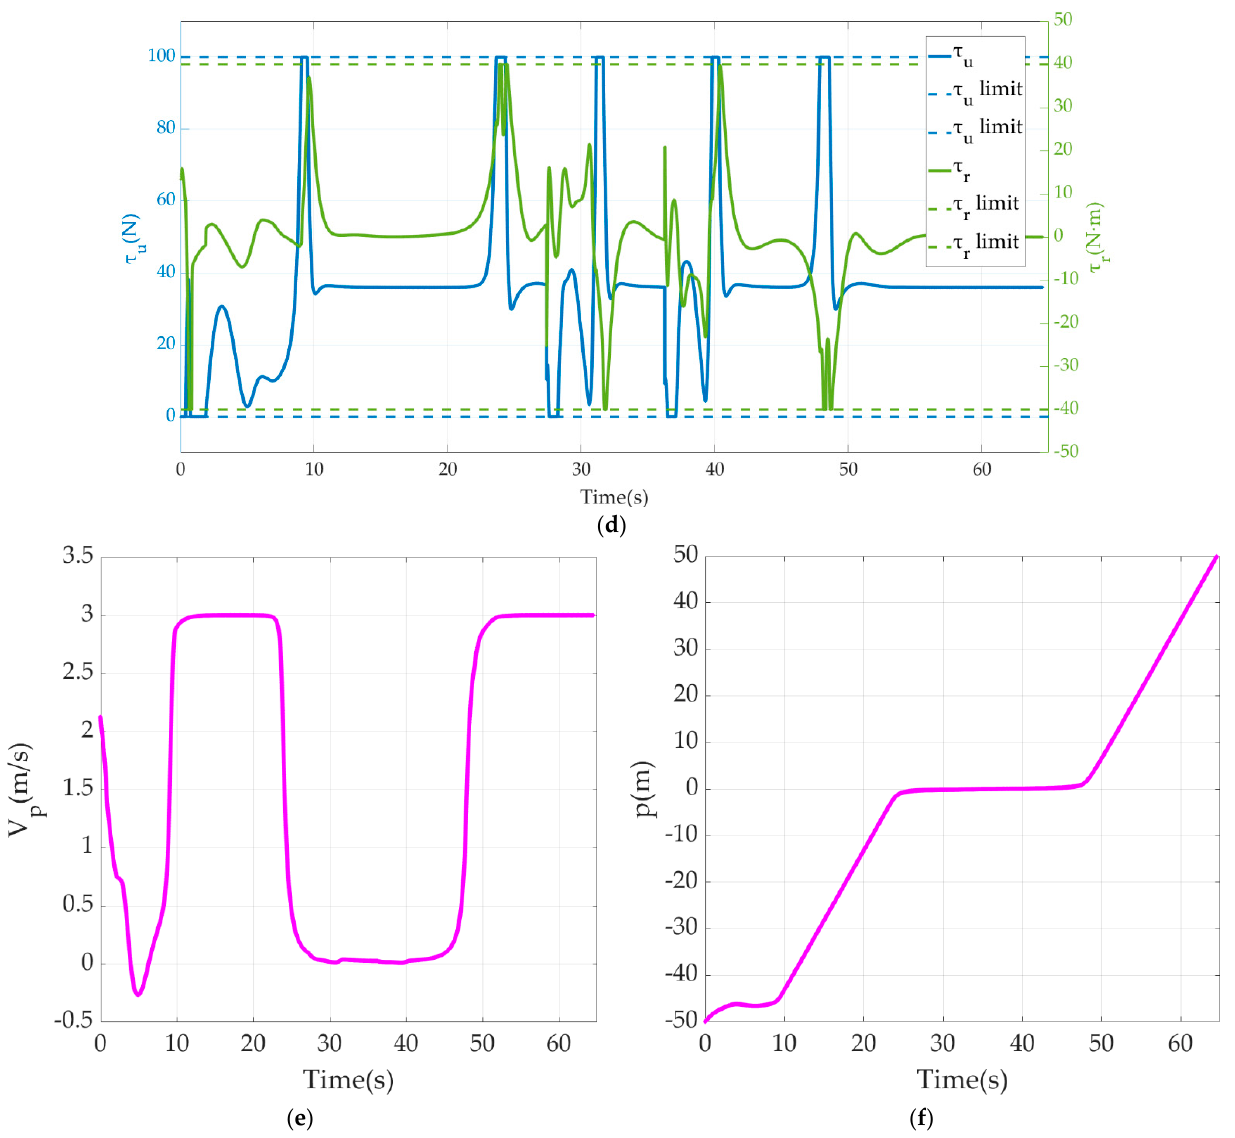
Figure 4. Results of USV underlying motion control: ( a ) USV 3-DOF motion data; ( b ) Tracking effect of RVC on expected velocity; ( c ) Tracking effect of NBCC on LOS guidance law; ( d ) Thrust and torque output; ( e ) Reference point moving velocity on path curve; ( f ) Reference point position on path curve.